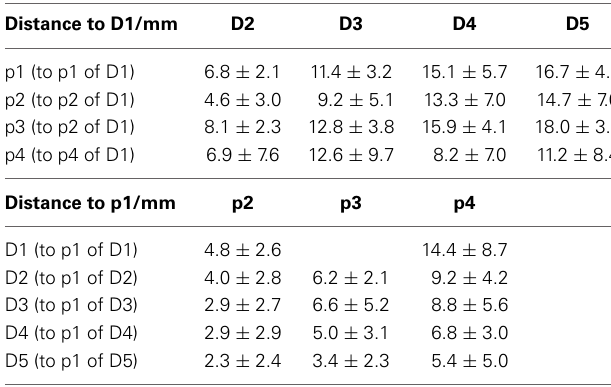
Table 3 | Euclidean distance across digits and within